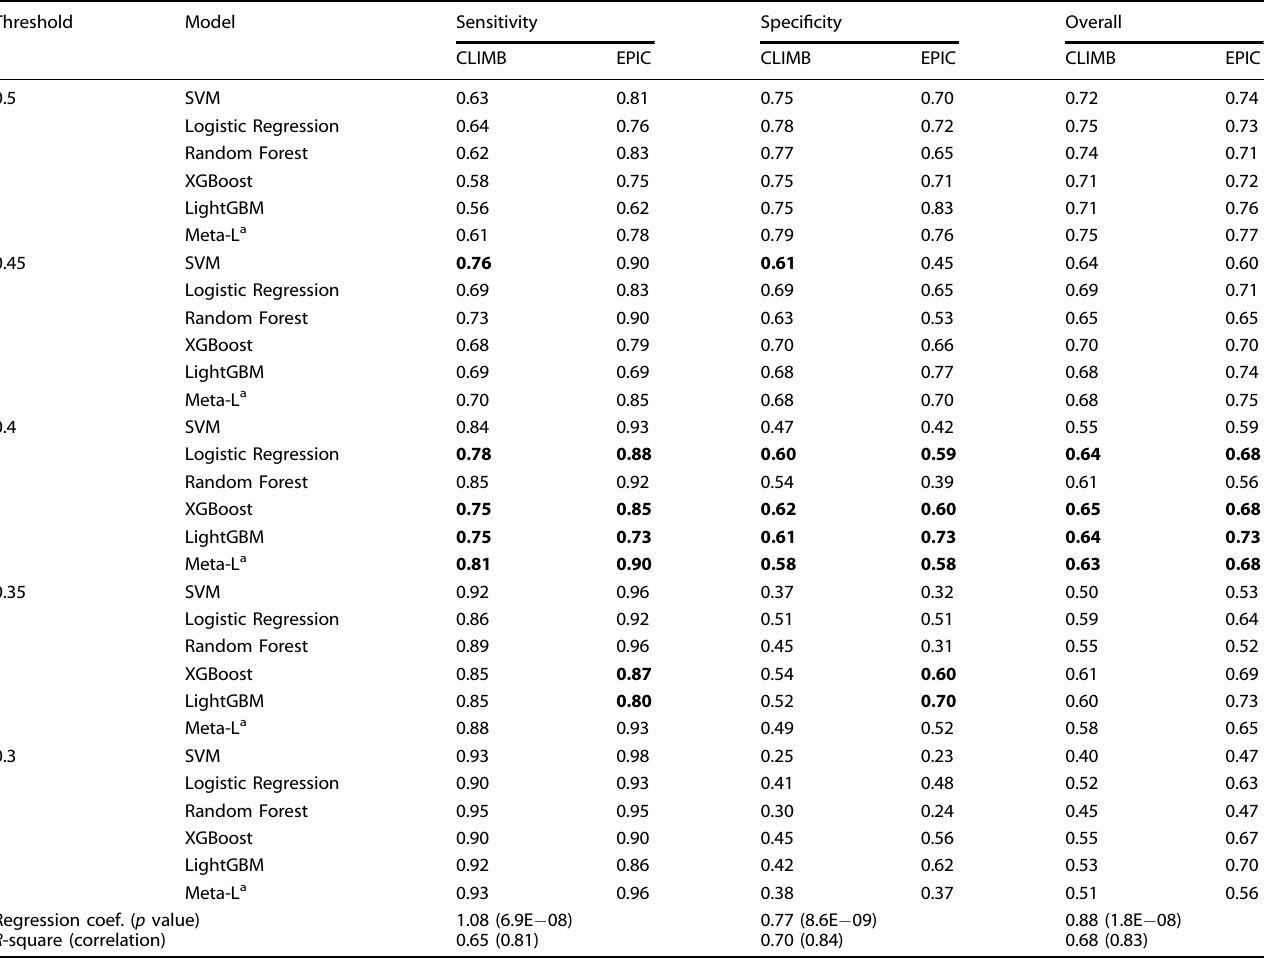
Table 2. Model validation using overlapping attributes and annual observations.